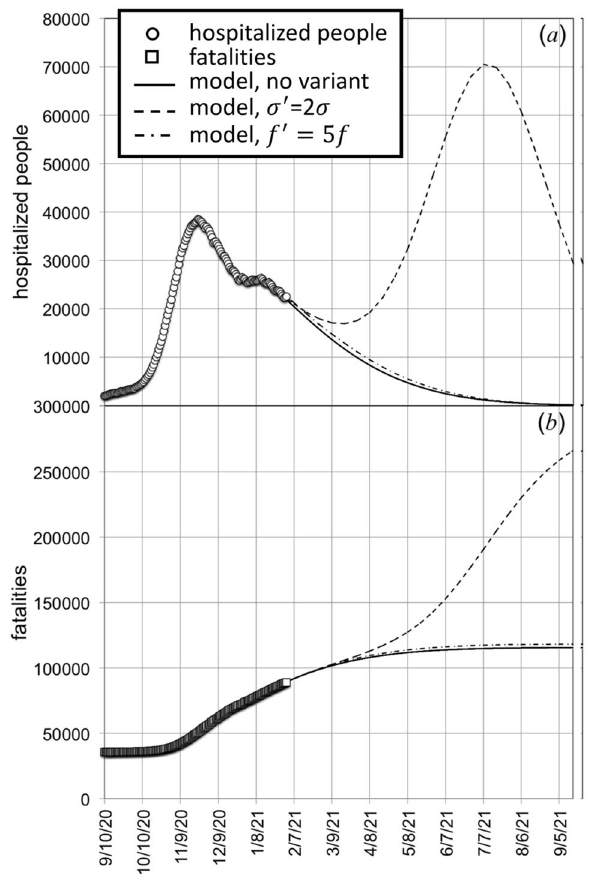
Figure 9. Simulation of impact of virus variant on the time evolution of hospitalized cases ( a ) and fatalities ( b ) in Italy. Calculations were performed by assuming that 1% of the active positives on January the 15th, 2021 were affected by a virus variant characterized by an infection cross-section higher by a factor 2 (dashed lines), or by a virus variant producing more severe symptoms, described by an increase by a factor 5 of the fraction of positives requiring hospitalization (dot-dashed lines). Continuous line is the predicted time evolution of cases in the absence of virus variants at the present level of mobility ( D/D L =